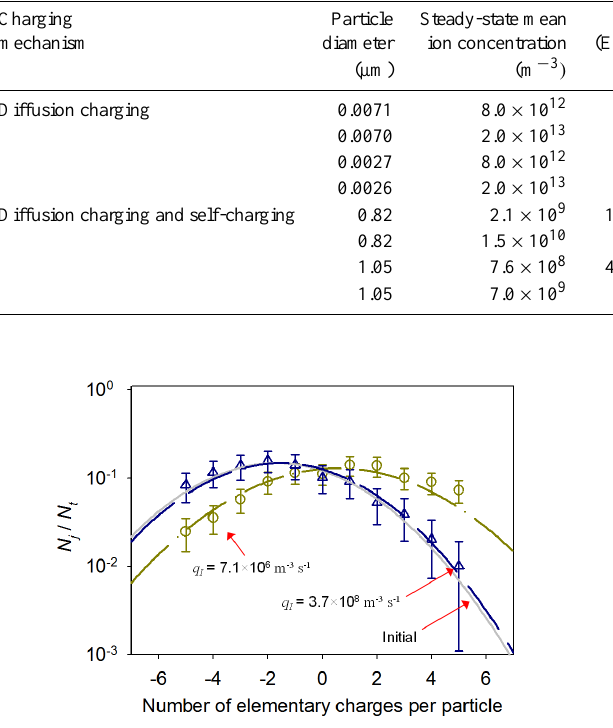
Figure 4. Charge distributions of 137 Cs particles under two ionizing conditions: q I = 7 . 1 × 10 6 m − 3 s − 1 and q I = 3 . 7 × 10 8 m − 3 s − 1 ( d p = 0 . 82µm; A Cs-137 = 12 . 8mBq). The prediction results of Ap- proach 2 were compared with the measurements of Gensdarmes et al. (2001).